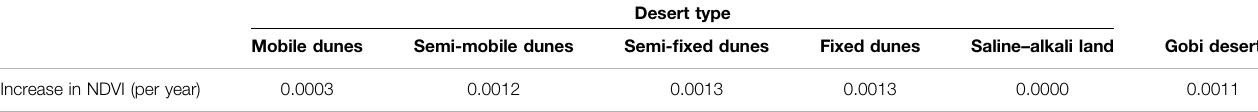
TABLE 4 | The annual mean rate of increase of the normalized-difference vegetation index (NDVI) from 1998 to 2015 for the six desert